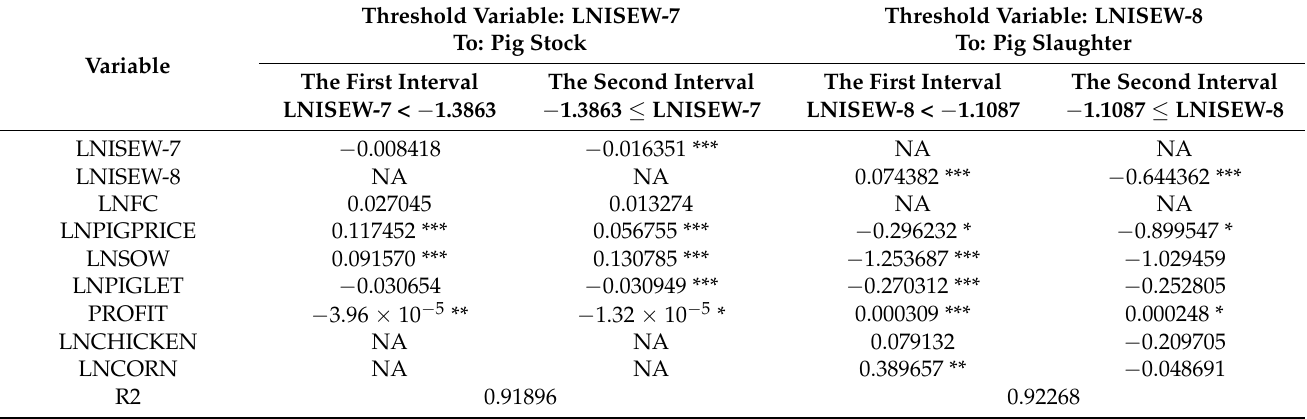
Table 3. Threshold regression